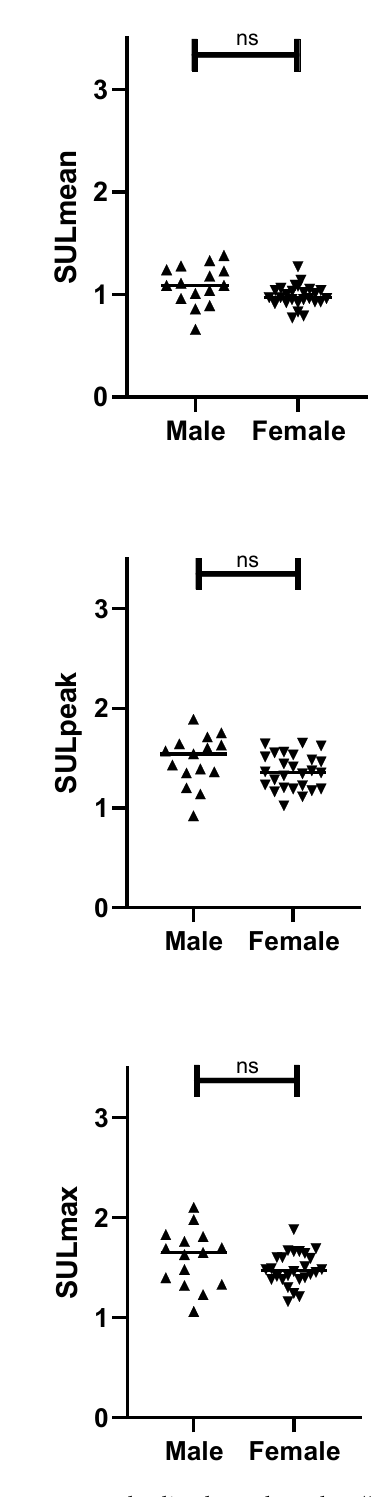
Figure 2. Sex differences in blood pool activity as measured by the mean standardized uptake value (SUV mean ), peak standardized uptake value (SUV peak ), maximum standardized uptake value (SUV max ), mean standardized uptake value corrected for lean body mass (SUL mean ), peak standardized uptake value corrected for lean body mass (SUL peak ), and maximum standardized uptake value corrected for lean body mass (SUL max ). Results from t-tests are shown in the graphs, with * = p < 0.05 and ns = not significant.